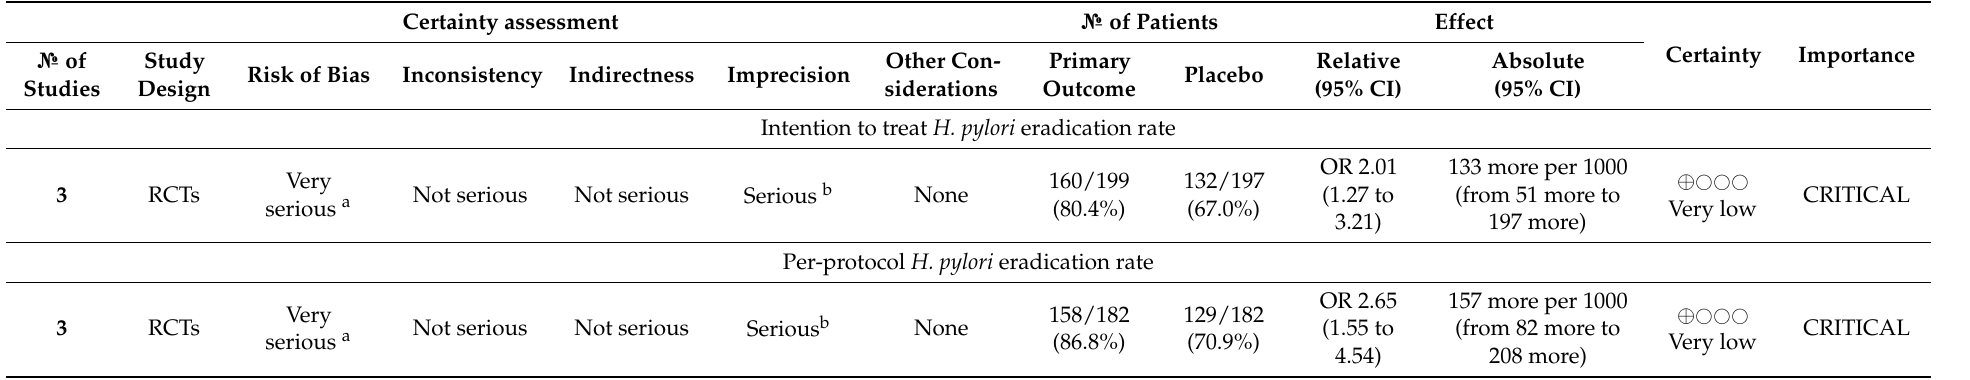
Table 4. GRADE evidence